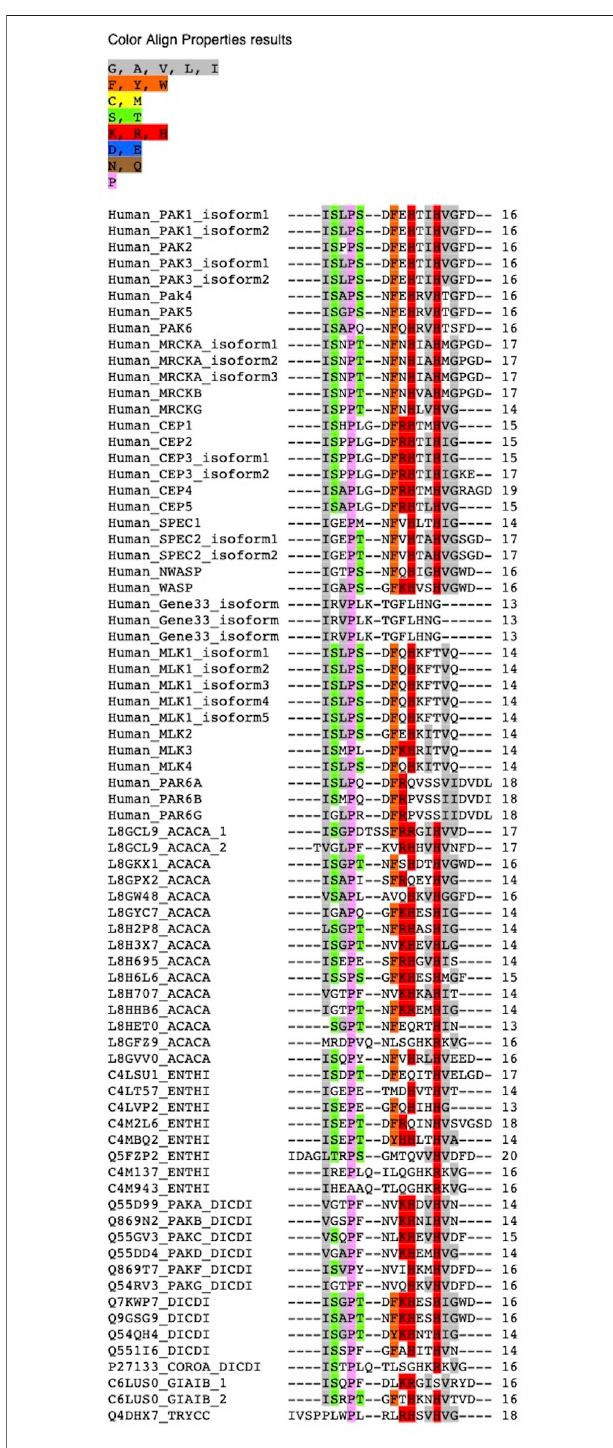
FIGURE 1 | Sequence alignment of conserved CRIB motif of all the proteins of human, Dictyostelium discoideum , Acanthamoeba castellani , Entamoeba histolytica extracted from domain-based search from